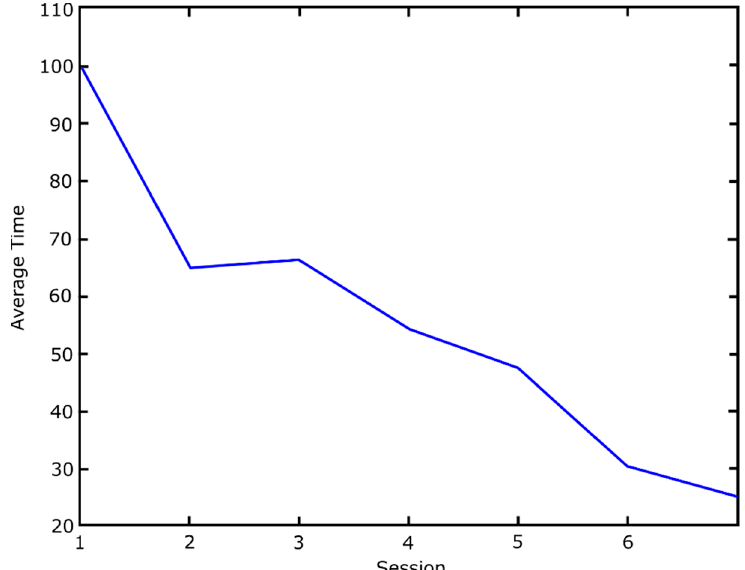
Figure 9. Execution times of “guess the movements” exercise.